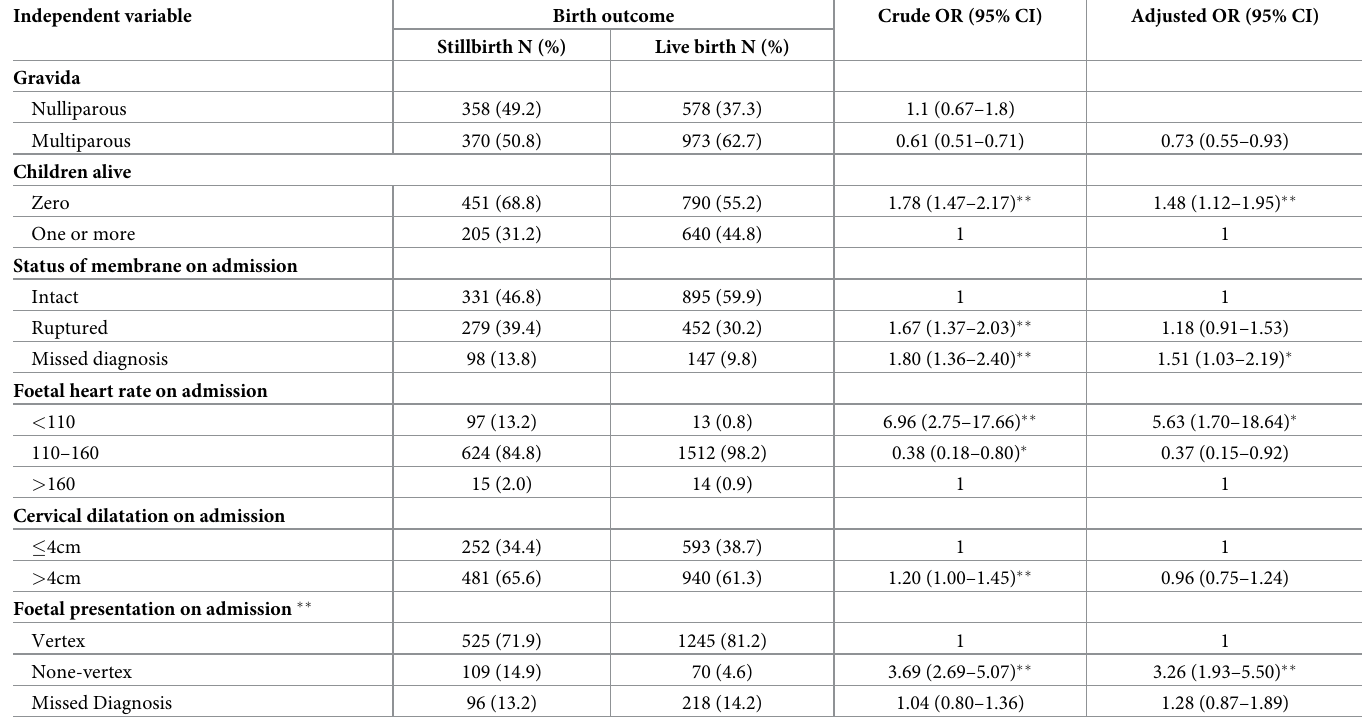
Table 3. Multiple logistic regression analysis to detect independent effects of key